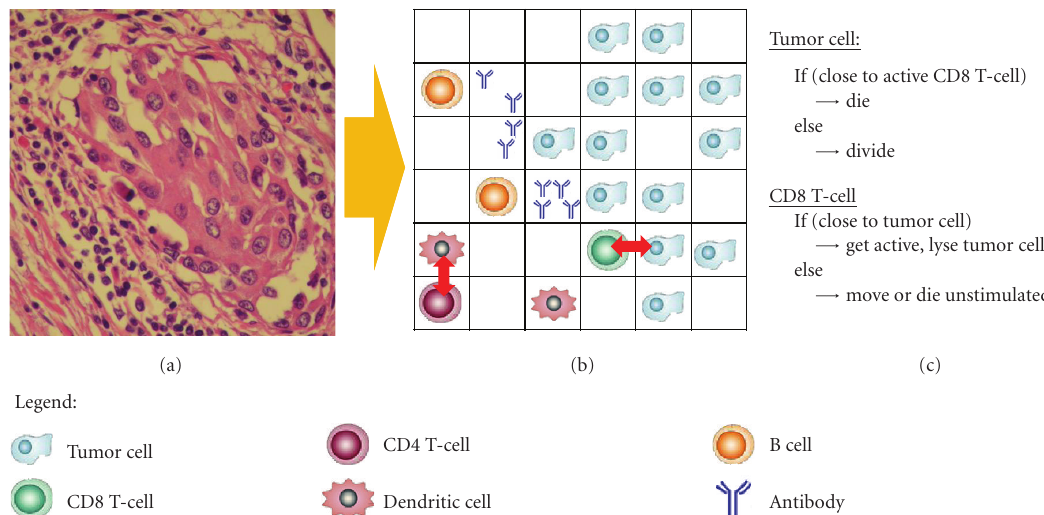
Figure 3: Agent-based modeling. (a) Lymphocytes infiltrating an urothelial carcinoma of the bladder. (b) Translation to an ABM. Cells move and interact in a grid. Each cell can occupy one grid space, while antibodies or cytokines have a continuous concentration at each grid space. (c) A simplified part of the underlying rules for the agents is